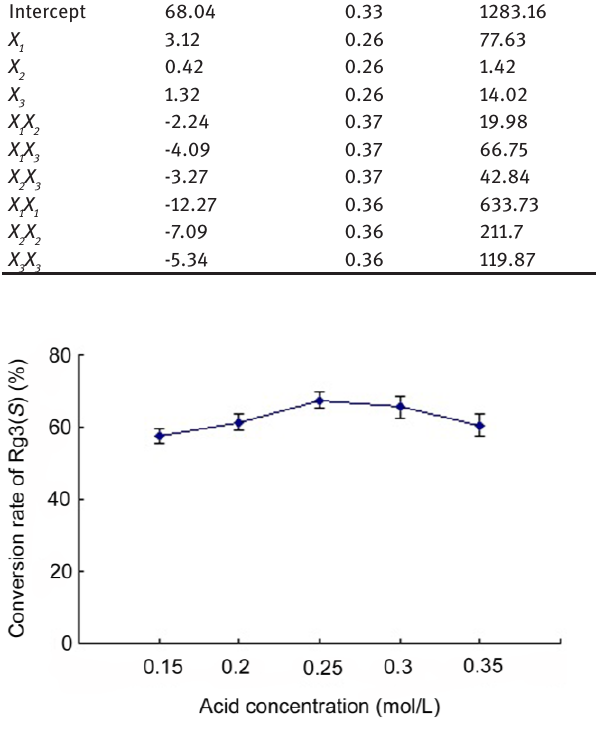
Figure 6: Effect of acid concentration on the conversion rate of ginsenoside Rg3( S ). electric field intensity 20 kVcm -1 and pulse number 12.